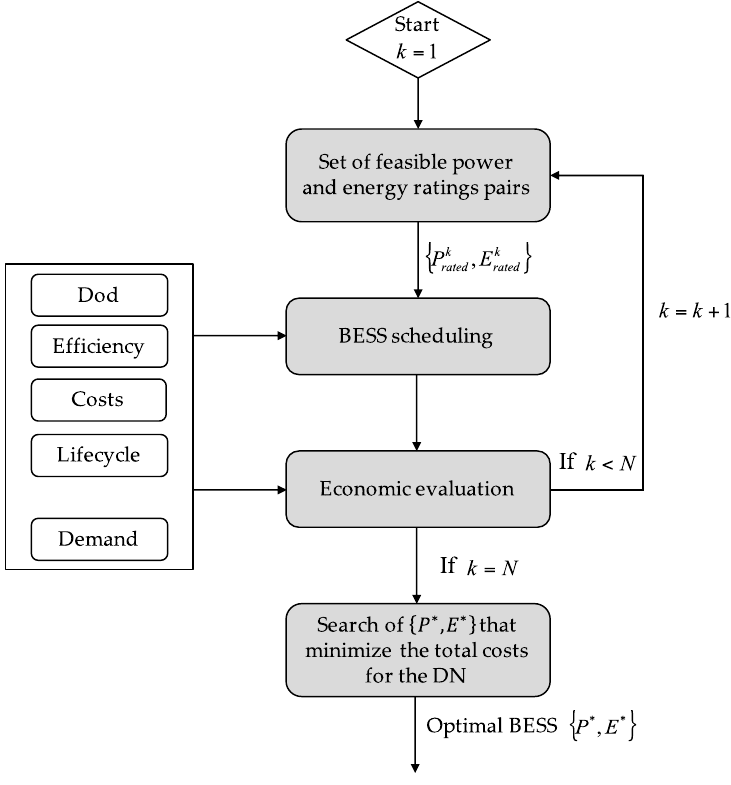
Figure 1. Flowchart of the proposed methodology for sizing of BESS.